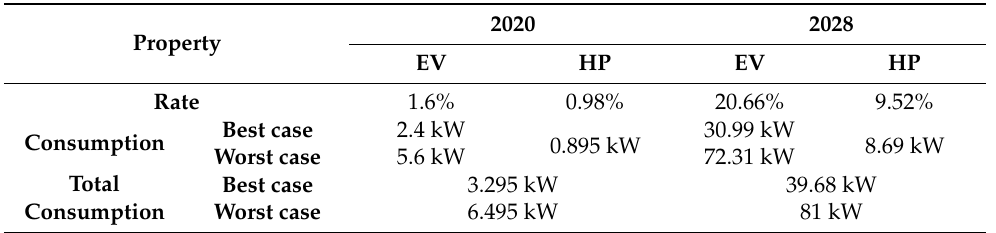
Table 7. Mains’ cable loading for 2020 and 2028.